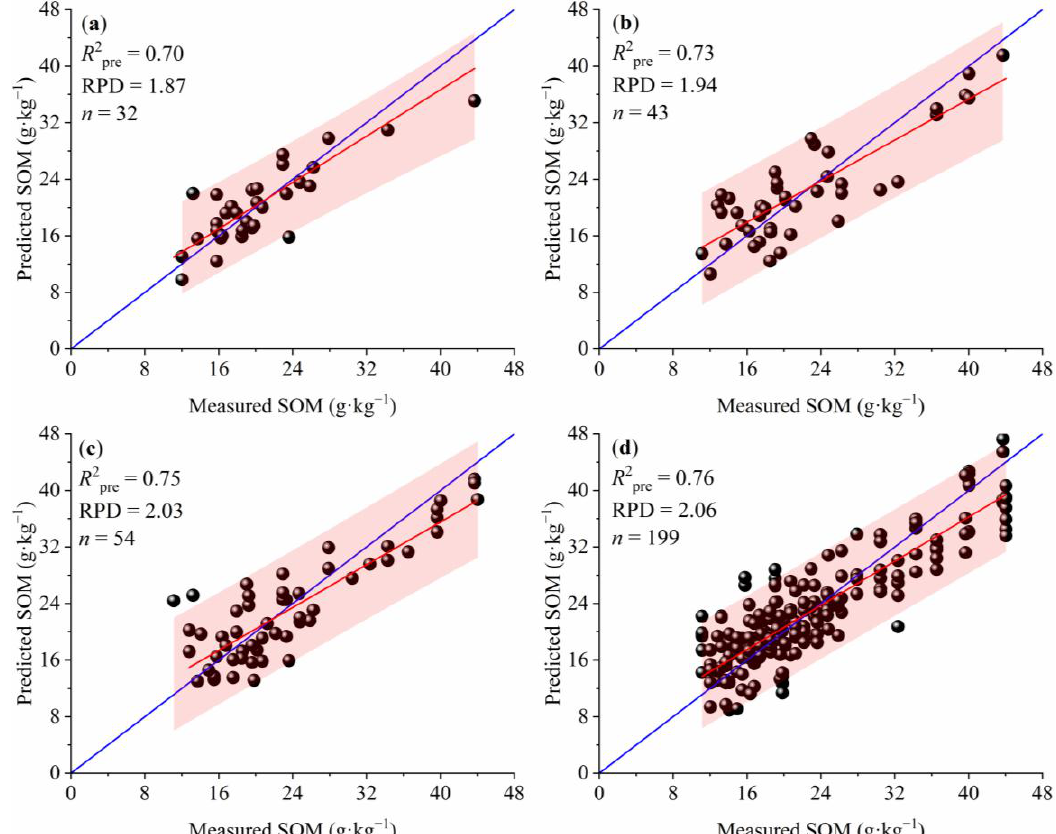
Figure 10. Validation scatter plots between laboratory-measured SOM and VIS–NIR predicted SOM obtained from PLS-SVM using NSMI–based cluster method: ( a ) cluster 1; ( b ) cluster 2; ( c ) cluster 3; and ( d ) cluster 4. The regression statistics ( R 2 pre , RPD) for independent validation dataset are illustrated in the upper left corner of the four subplots. The blue lines are the 1:1 line, and the red lines are the regression line. The colored regions in the four subplots represent 95% prediction confidence intervals for covering the future data points. n : the number of soil samples.